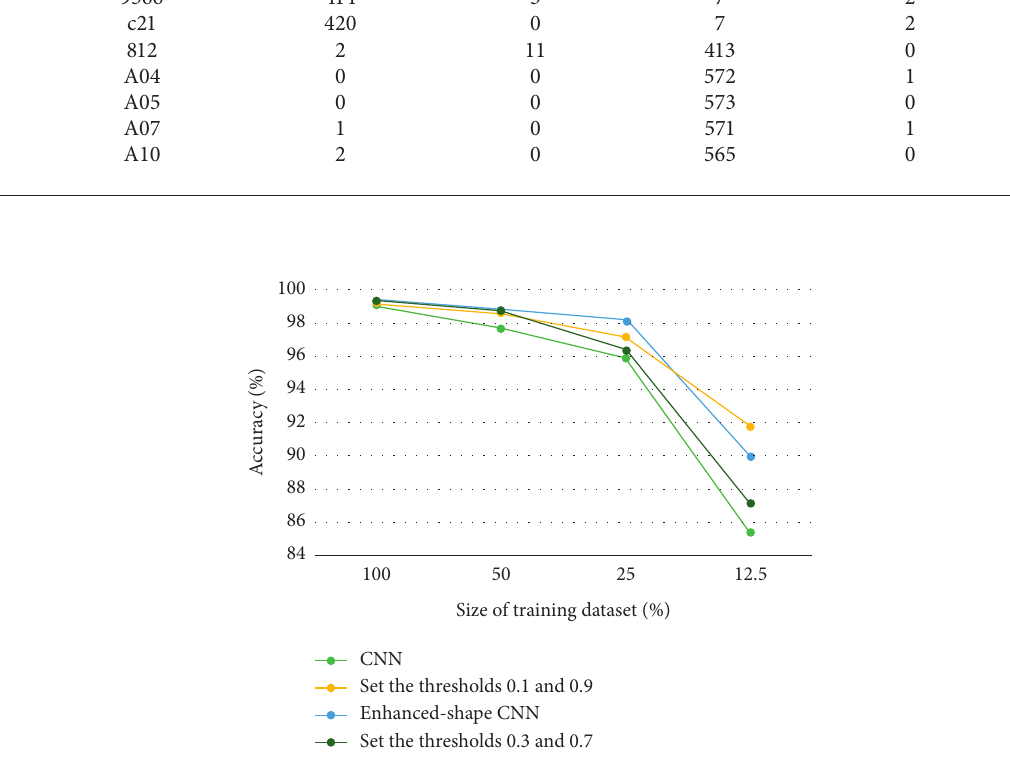
Figure 14: Recognition results under different segmentation